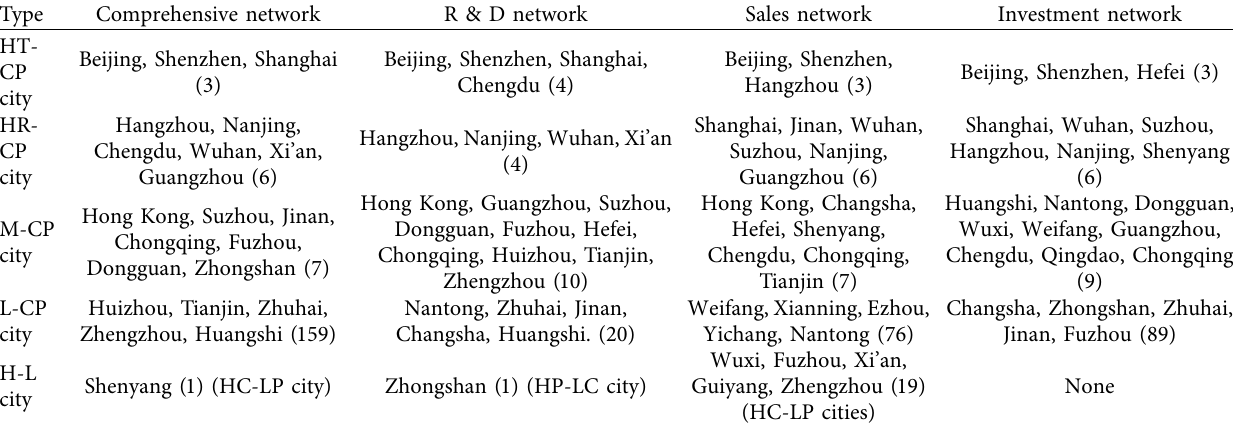
Table 5: City types according to the relationship between centrality and power